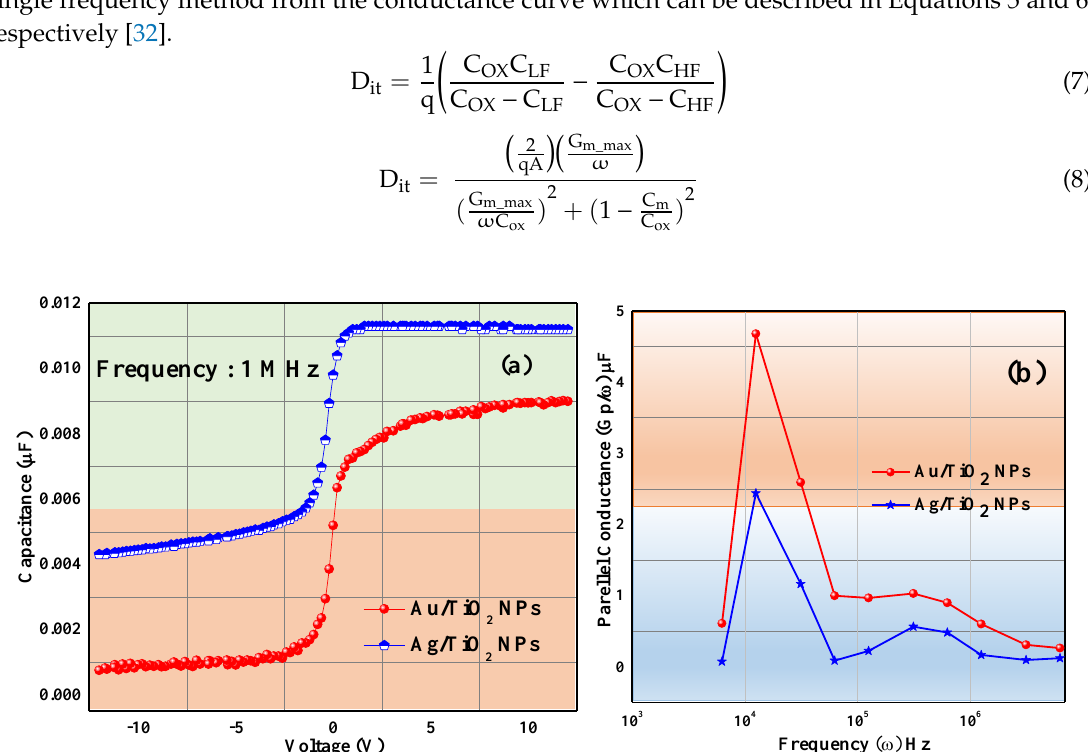
Figure 6. ( a ) C – V characteristics for the Ag/TiO 2 NPs and Au/TiO 2 NPs memristors under different Figure 6. ( a ) C–V characteristics for the Ag / TiO 2 NPs and Au / TiO 2 NPs memristors under di ff erent sweeping voltages at 1 MHz ( b ) G p/ ω Vs ω at 0 V. sweeping voltages at 1 MHz ( b ) G p / ω Vs ω at 0